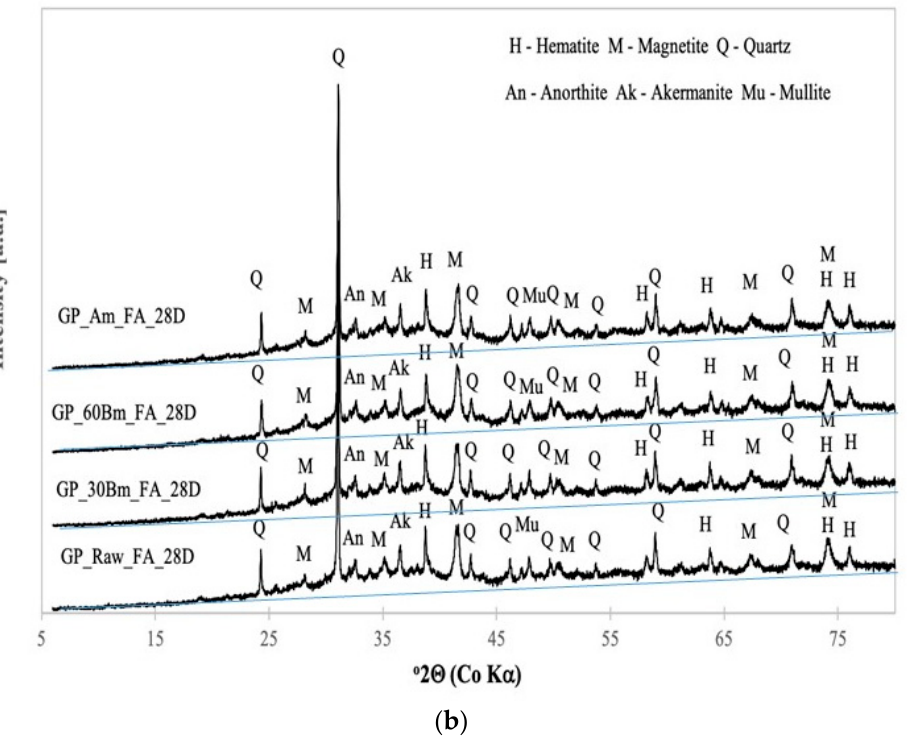
Figure 4. XRD patterns of the geopolymer pastes cured for ( a ) 7 days and ( b ) 28 days. Thin lines show a linear extrapolation from data between 5 and 15 ◦ to 80 ◦ for experimental baseline for better visualization of the amorphous contribution with respect to the crystalline contribution given by the diffraction peaks.